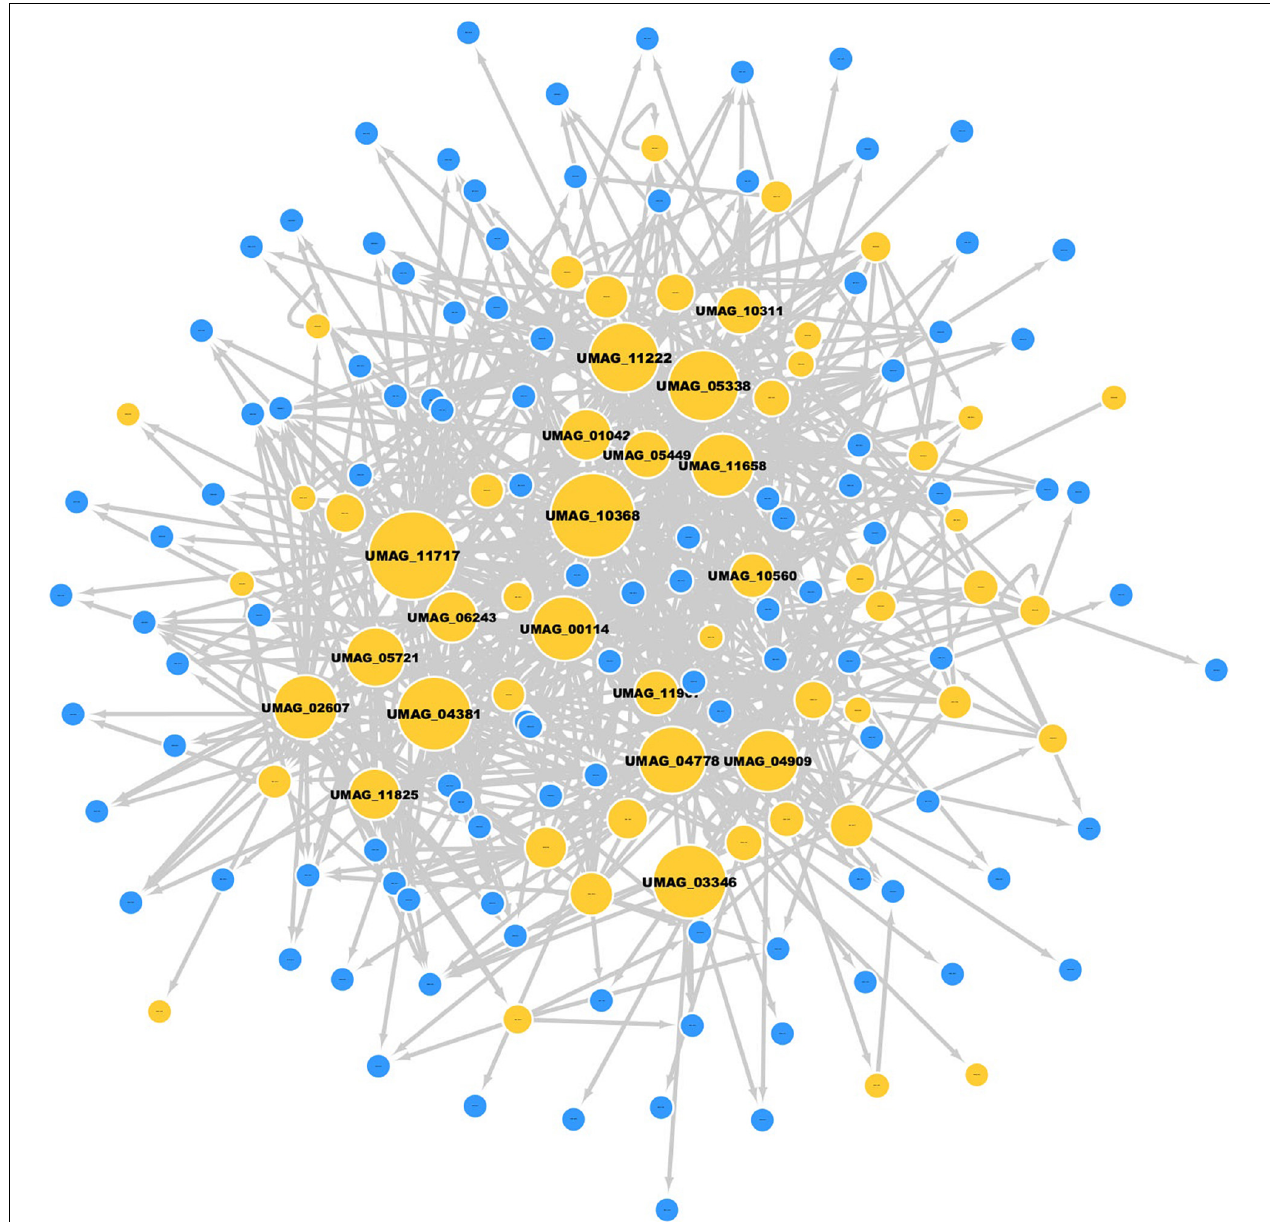
FIGURE 4 | Cell death module in U. maydis. Nodes in yellow represent TFs, and nodes in blue are TGs; the gray edges represent regulatory interactions. The size of a node is proportional to its degree of output.